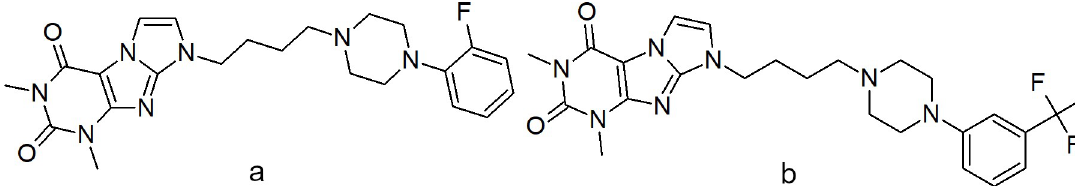
Fig 1. Chemical structures of the studied compounds AZ-853 (a) and AZ-861